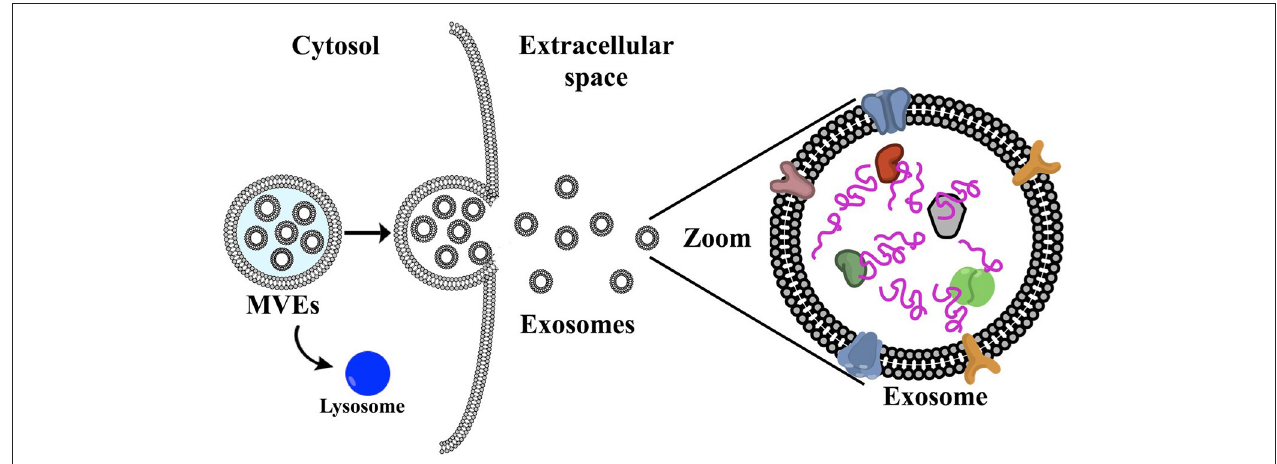
FIGURE 1 | (a) Schematic representation of exosome biogenesis: first, multivesicular endosomes are formed (MVEs), which encompass the exosomes. The MVEs can either fuse with the plasma membrane, releasing the exosomes into the extracellular matrix (see zoomed schematic), or fuse with the lysosome for degradation. Microvesicles are formed via direct blebbing from the plasma membrane. Exosomes contain protein, DNA, RNA and surface membrane proteins, which are specific to the cell of origin and are not limited to cell surface proteins (Colombo et al.,